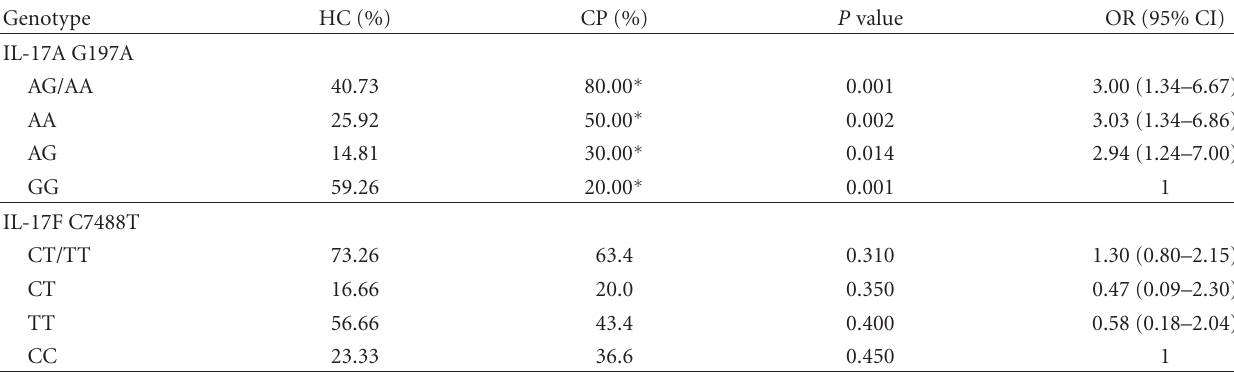
Table 3: Genotypes of IL-17 polymorphisms in patients with chronic periodontitis (CP) and healthy controls (HCs). Genotype